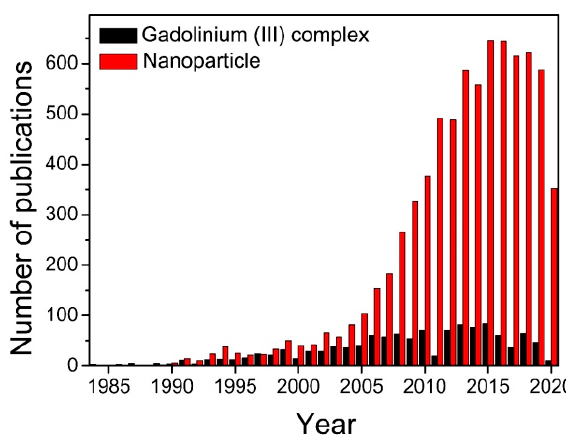
Figure 2. The number of publications searching for “magnetic resonance imaging and contrast agents” plus “gadolinium (III) complex” or “nanoparticle” in the “Web of Science”. Development of nanoparticle-based MRCAs has been the hot topic of the area since 2005.